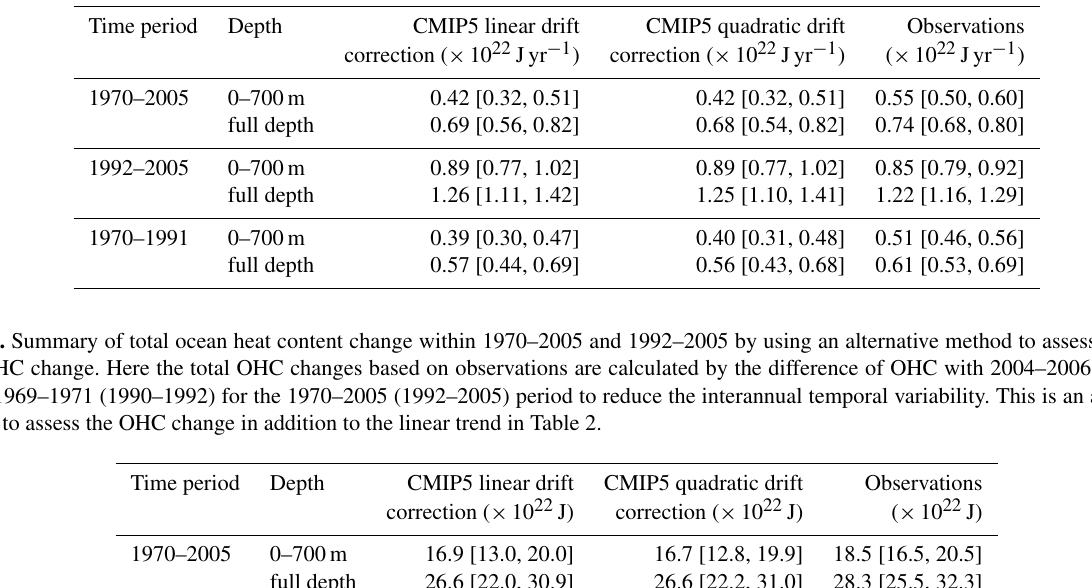
Table 2. Summary of ocean heat content change. Comparison of CMIP5 models and observations. The medians with the 5–95% confidence interval are presented.